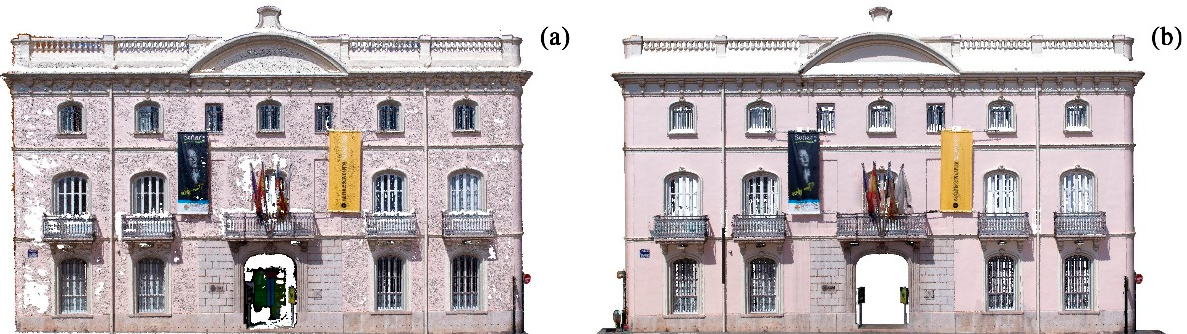
Figure 9. ( a ) Photogrammetric point cloud; ( b ) LiDAR point cloud colourised from the digital images oriented during the photogrammetric process.